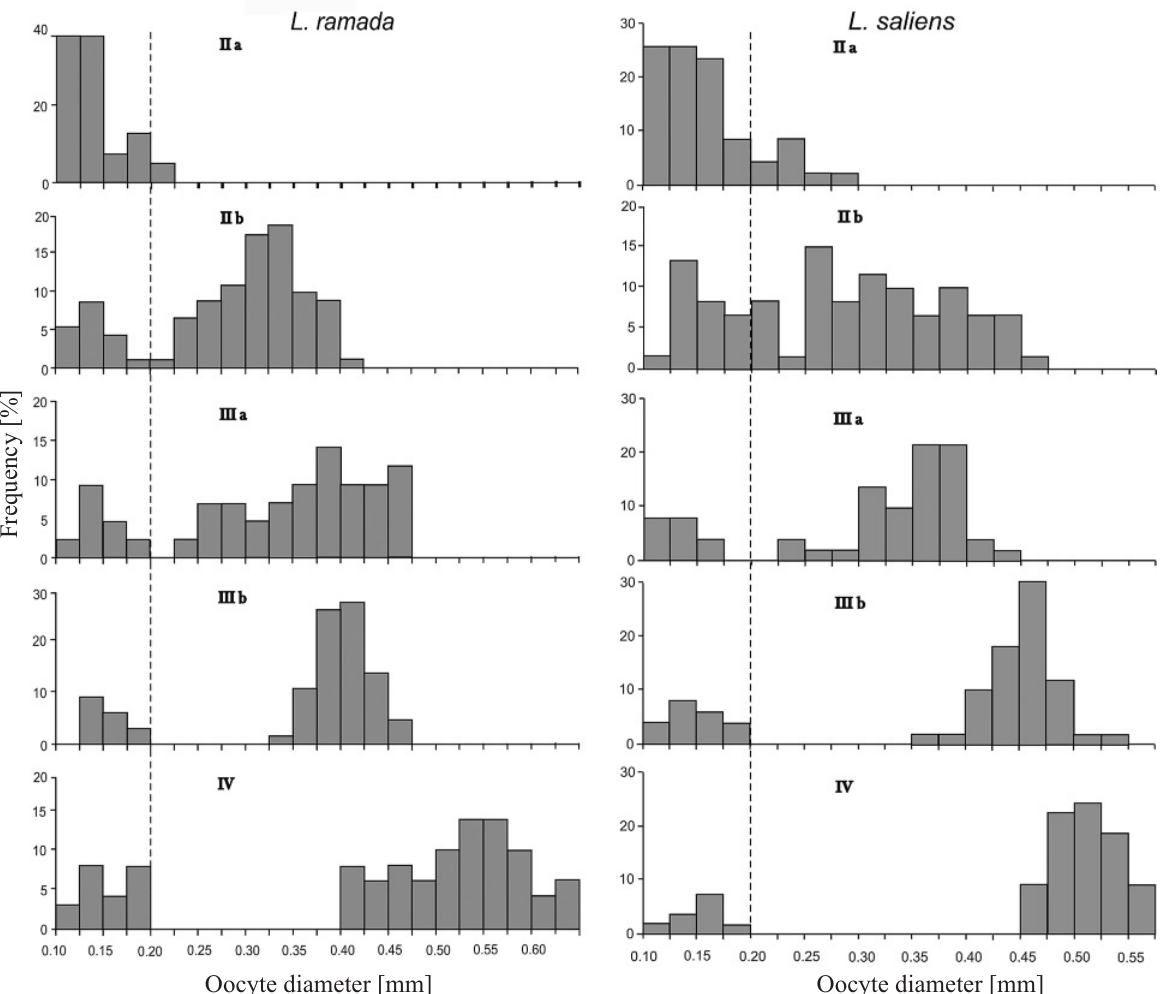
Fig. 6. Size-frequency profile corresponding to stages of oocyte maturity, used in order to estimate fecundity of